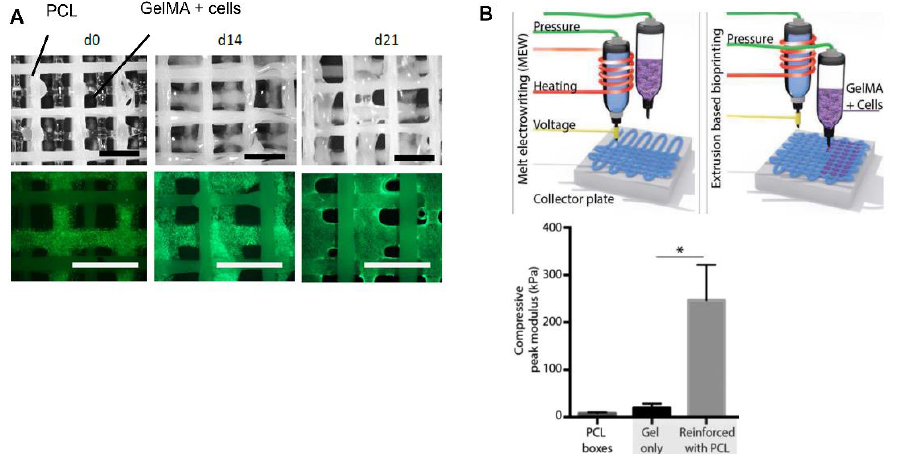
Figure 9. GelMA-based scaffold: ( A ) Representative bright-field and fluorescence images of hybrid scaffolds composed of PCL and GelMA. Scale bar = 2 mm. Adapted from [68]. ( B ) Schematic image of extrusion-based bioprinting and electrowriting techniques that improved scaffold mechanical properties * = p < 0.05. Adapted from [69].